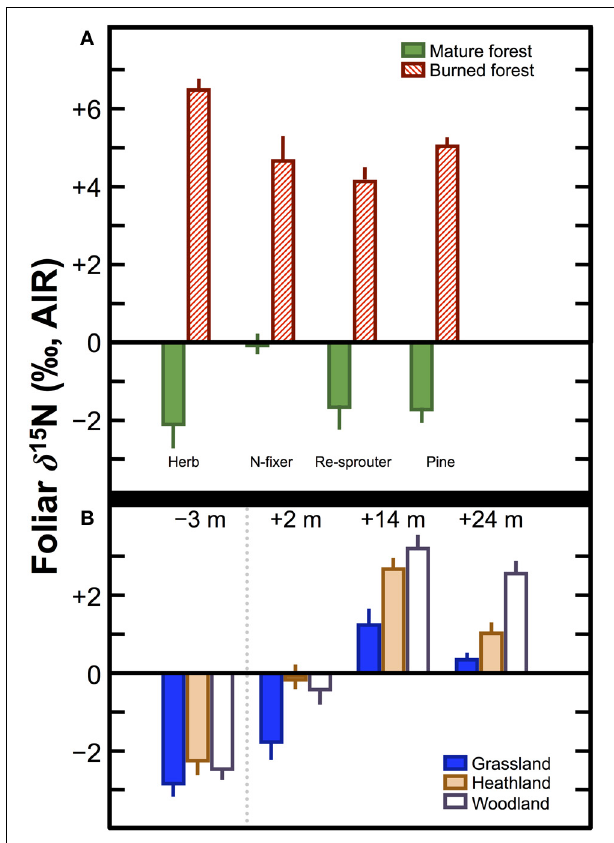
FIGURE 6 | Effects of fire on plant δ 15 N values. (A) Comparisons between plants grown on mature and recently burned California pine forests (Grogan et al., 2000). (B) Change over time in three different Australian ecosystems following substantial wildfires. Values above indicate number of months prior to or after the wildfires. The broken vertical line separates the pre- and post-fire samples (Huber et al., 2013). In both (A,B) bars represent means ± one standard